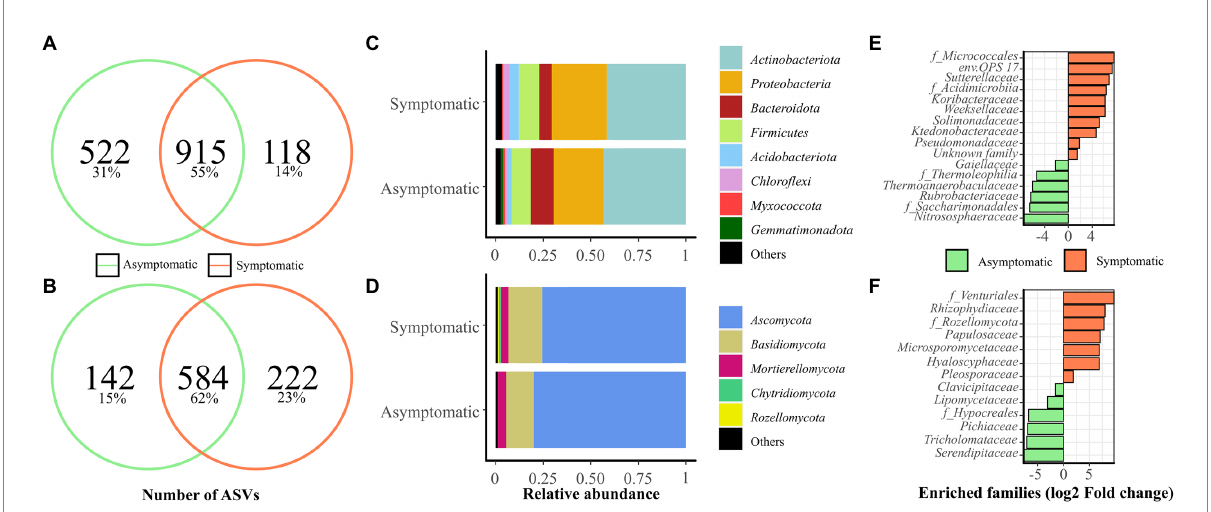
FIGURE 1 Microbial communities present in symptomatic (S) and asymptomatic (AS) soils from vineyard. Soil samples were collected in April 2019 and 2020 in each area ( n = 6). Venn diagrams show the number of shared and specific ASVs for (A) bacterial, and (B) fungal communities. Abundances at phylum level are presented for (C) bacterial and (D) fungal communities. Phyla representing less than 1% of the total reads were grouped in “Others.” Enriched (E) bacterial and (F) fungal classes, orders, and families using Limma-Voom differential analysis ( p < 0.001) corrected with FDR are